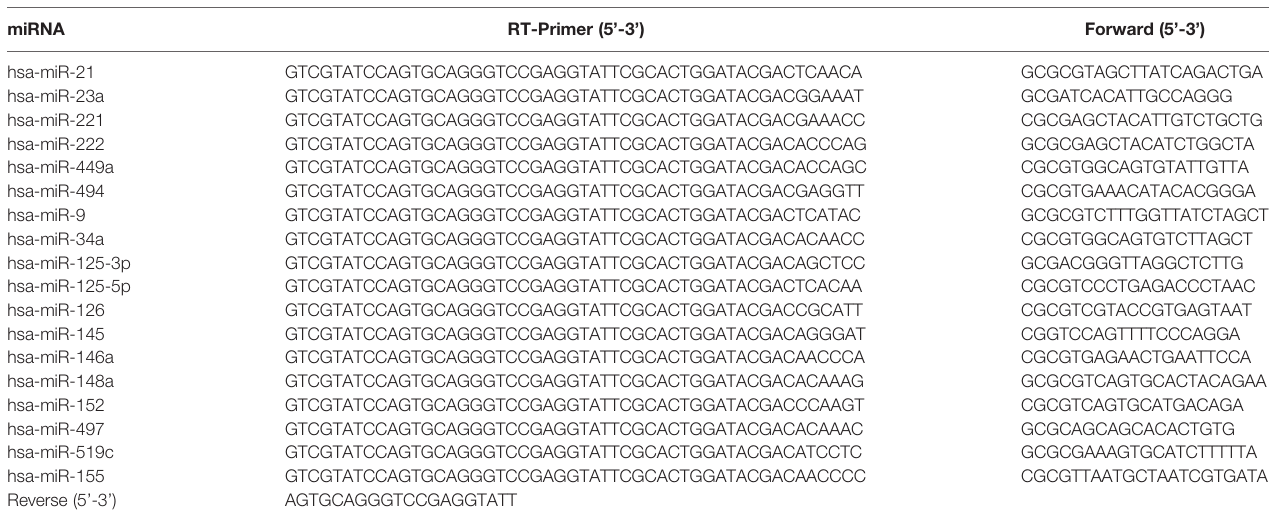
TABLE 1 | List of miRNA